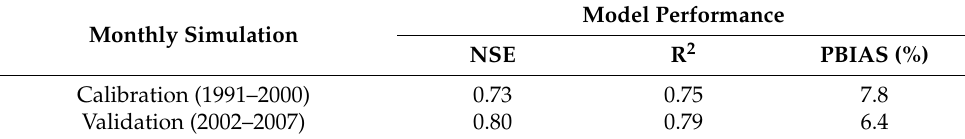
Table 5. Calibration and validation statistics of observed and simulated average sediment load.